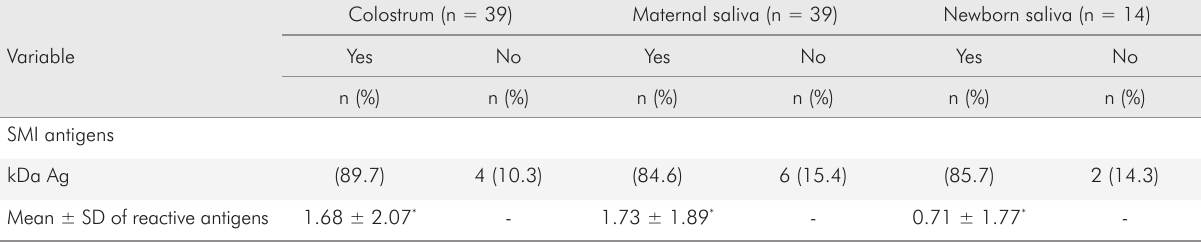
Table 2. Number and percentage of positive samples to S. mitis in colostrum, maternal saliva and newborn saliva reactive or not to the S. mitis antigen (56kDa-Ag). The mean and standard deviation of reactive bands in each group is also given.